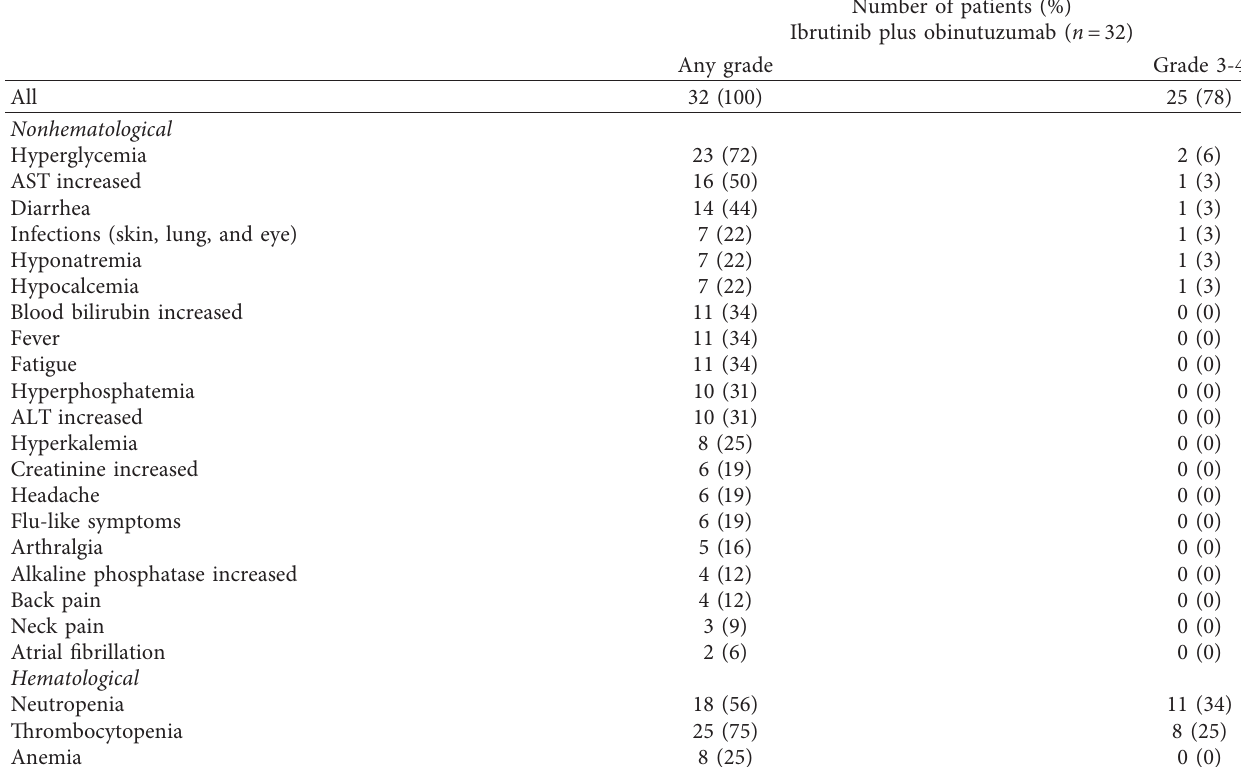
Table 2: Adverse